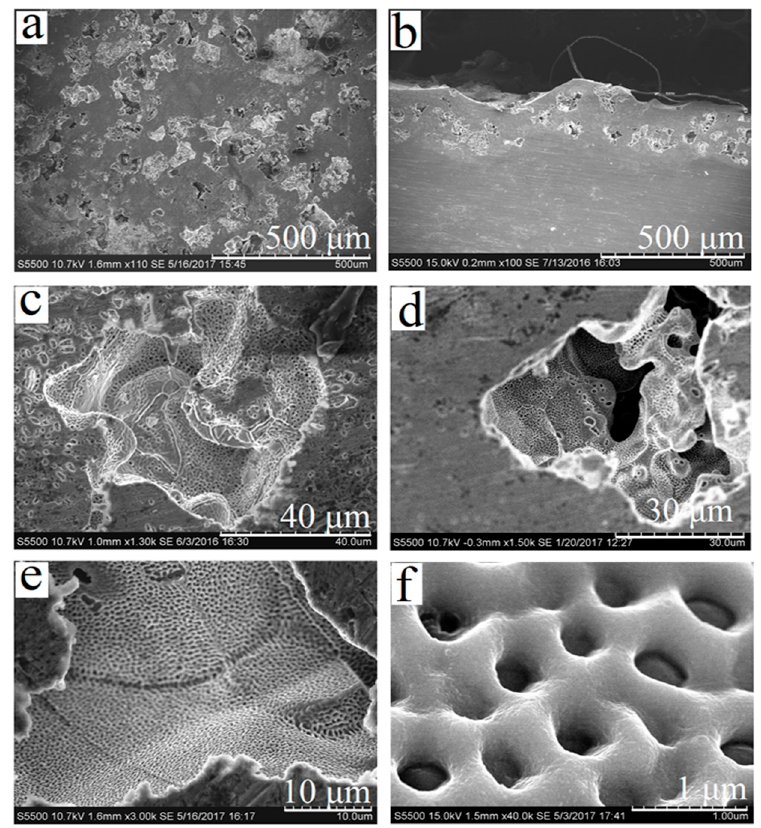
Figure 1. Porous surface of titanium samples after laser glazing with TiC powder (80 / 100 µ m fraction) and etching with nitric acid: ( a ) surface appearance of sample (110 × ); ( b ) cross-section of sample (100 × ); ( c , d ) individual pores (1300 × and 1500 × , respectively); ( e , f ) inner surface of pores (3000 × and 40,000 × , respectively).